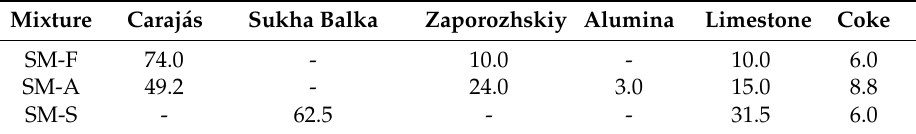
Table 3. Sintering mixtures blending scheme, wt %.